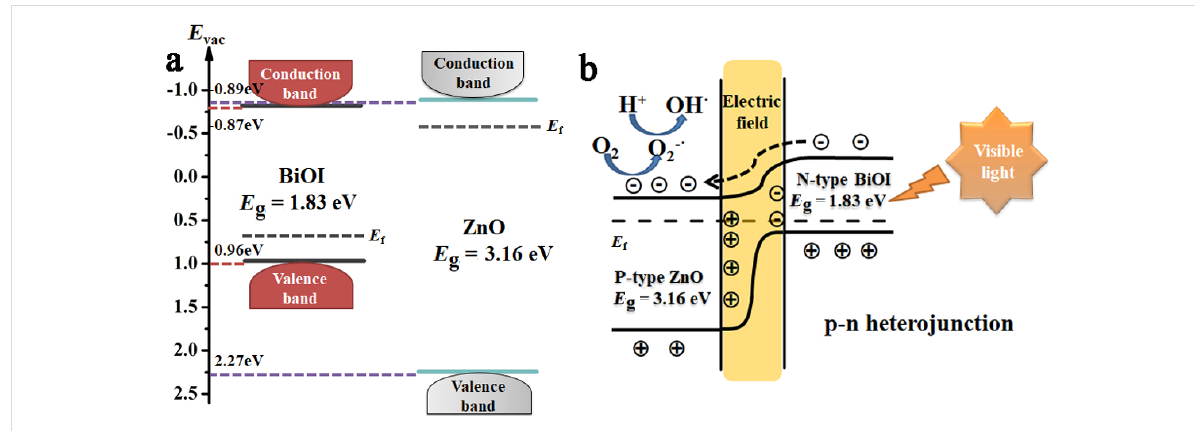
Figure 7: Schematic band energy diagram of BiOI and ZnO before (a) and after (b) interfacial